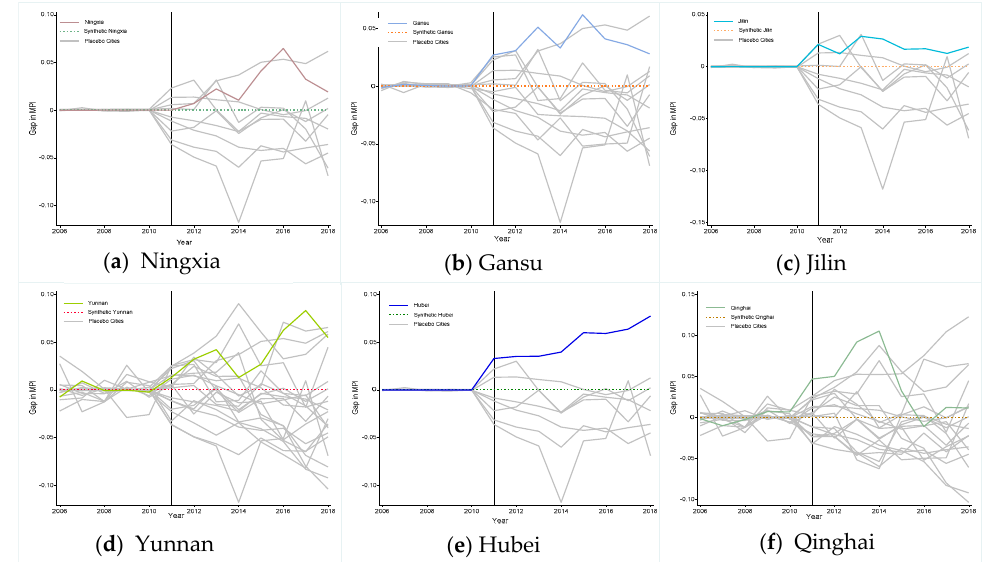
Figure 4. Permutation Test-MPI gaps in six treated provinces and placebo gaps in donor prov- inces.